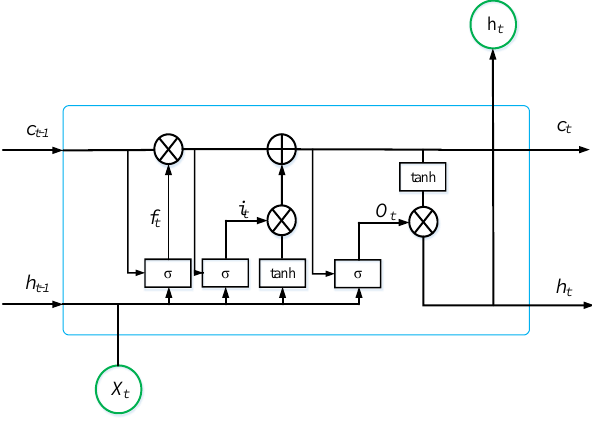
Figure 1. Diagram of a single layer Long Short-Term Memory cell.